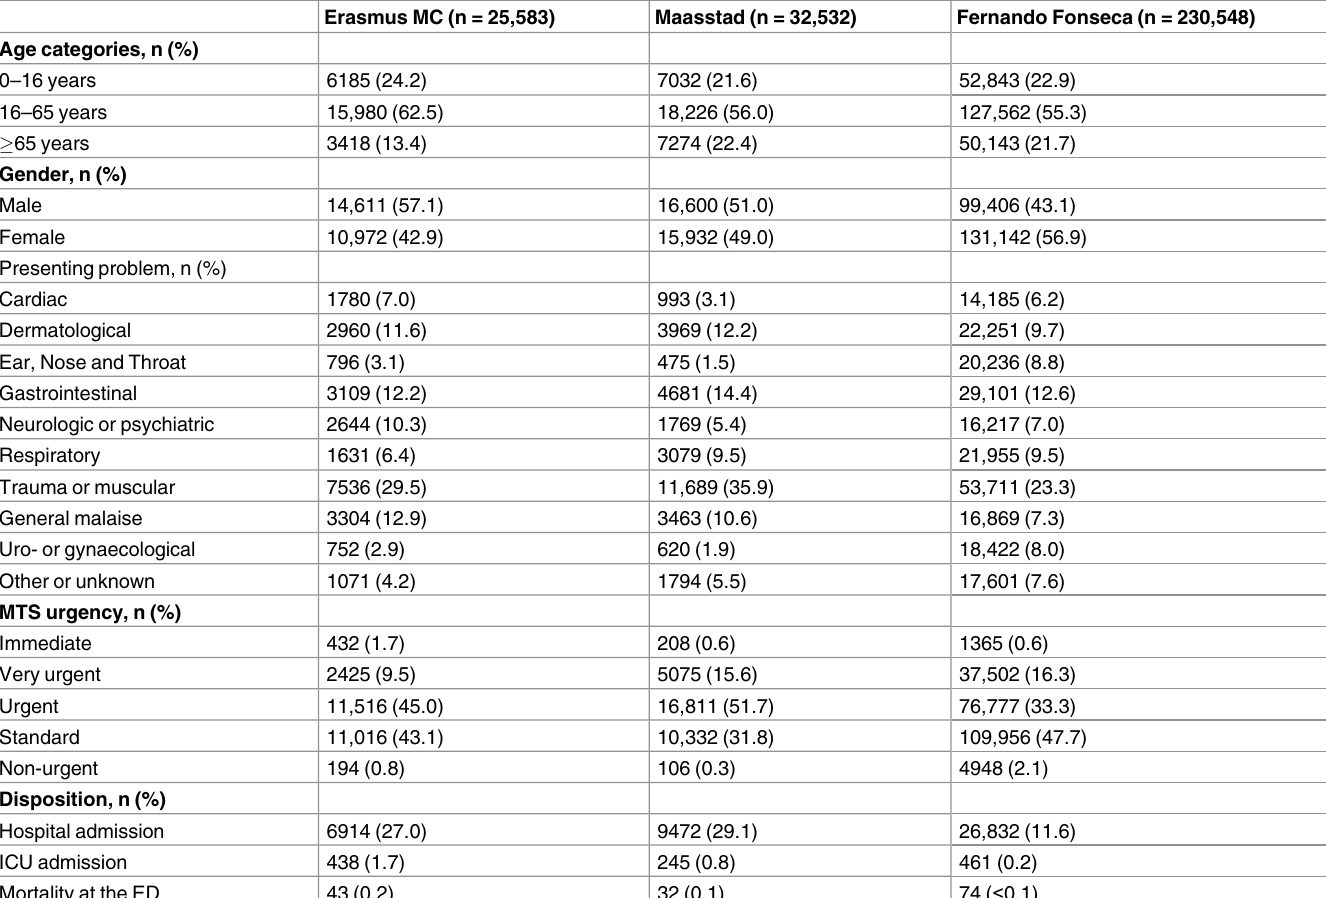
Table 2. Characteristics of the study population.